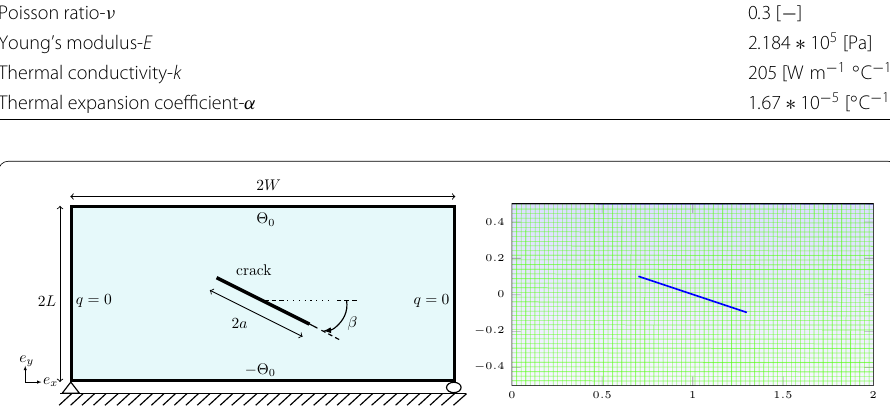
× E j . Material parameters R 2